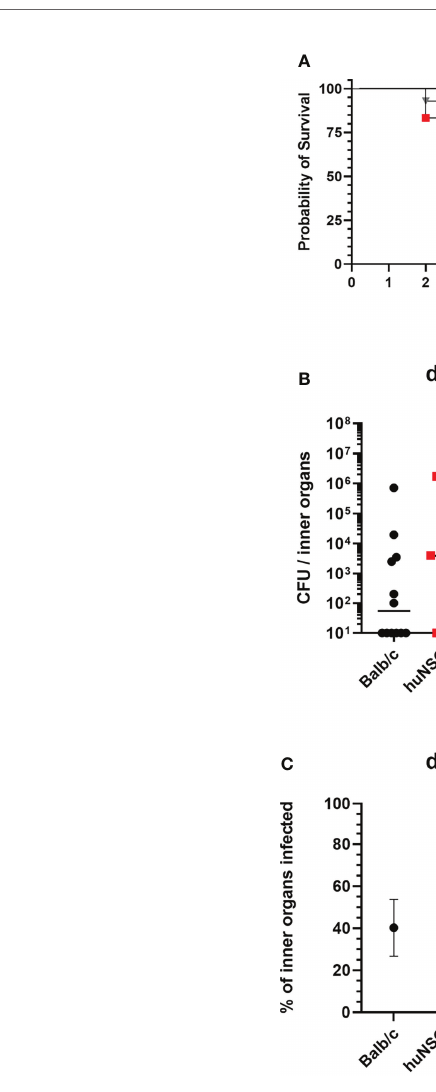
FIGURE 2 | Mortality of the locally infected mice, signs of systemic infection and humanization rates of the humanized mice groups. (A) Seven of 20 humanized mice and one of 14 wild-type NSG mice reached the humane end point during the course of infection. These mice were removed from the experiment and counted as “ dead ” . Statistically signi fi cant differences between the groups were tested with Log-rank (Mantel-Cox) test. (B) The spleen, heart, liver and kidneys were recovered at the indicated time points and the bacterial burden determined. Displayed are the individual values per mouse and the corresponding median per group. (C) The percentage of tested inner organs (kidneys, liver, spleen and heart) with bacterial burden per animal was calculated and the mean +/- SEM per group is displayed (n: huNSG = 12; NSG, wild-type = 14; Balb/c = 14; muNSG = 11). Statistical signi fi cance was tested with Kruskal-Wallis with Dunn ’ s post-test (B, C) (*p ≤